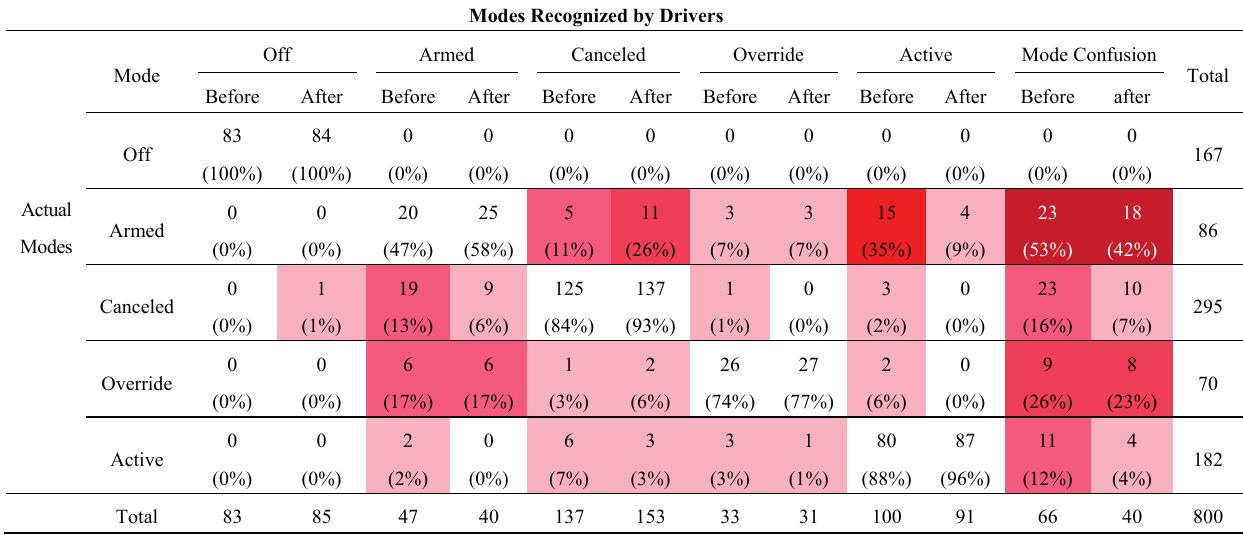
Table 8. Mode confusion rates before and after glancing at the five-mode interface in the experiments.